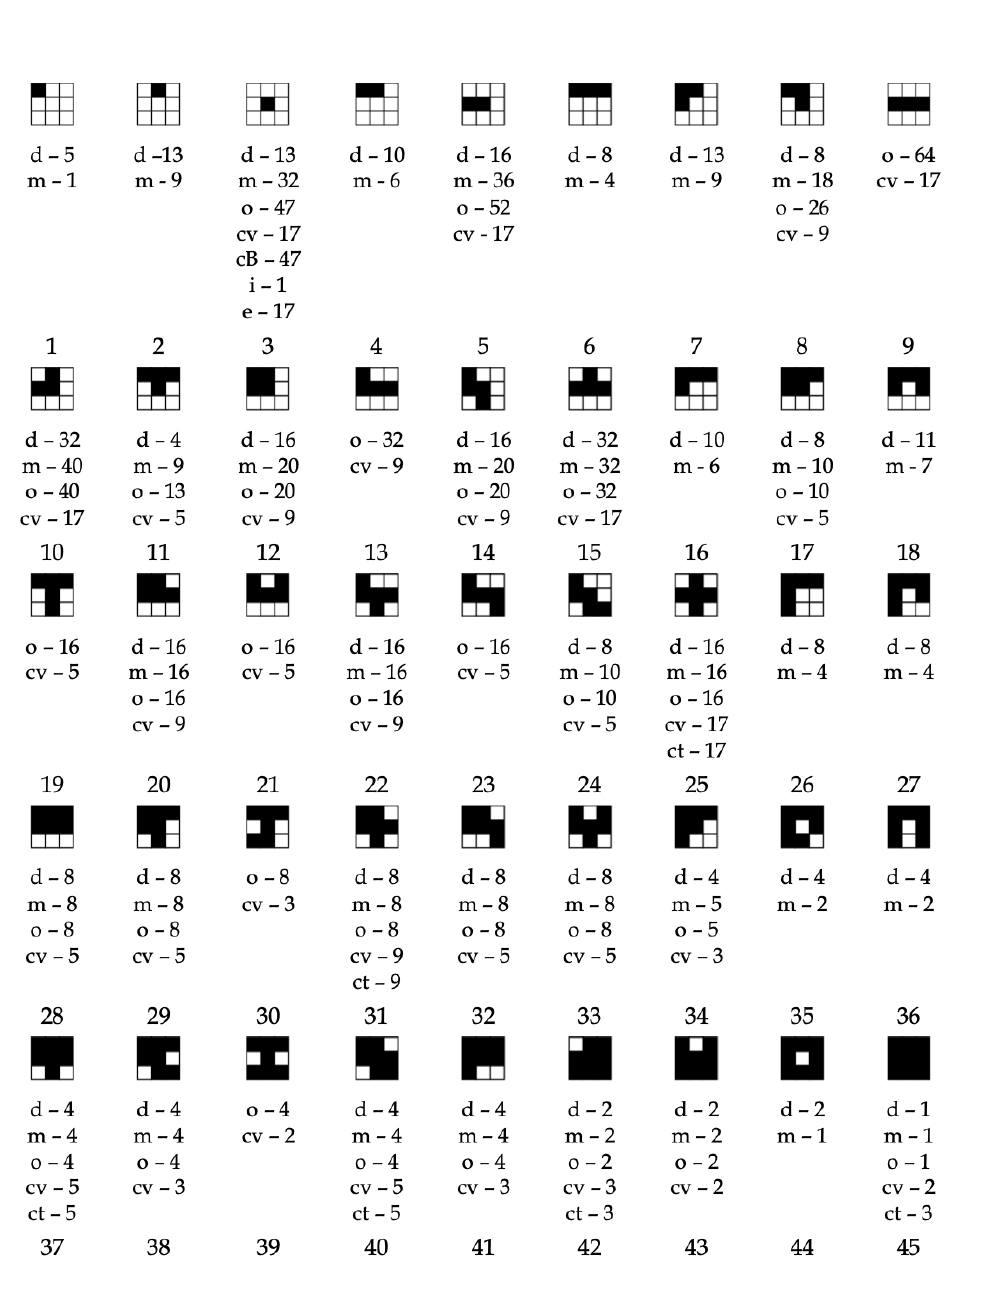
Figure 13: Topological augmentations from the congruence class that can produce the named topological relation. The numbers presented reflect only one symbol from the con- gruence